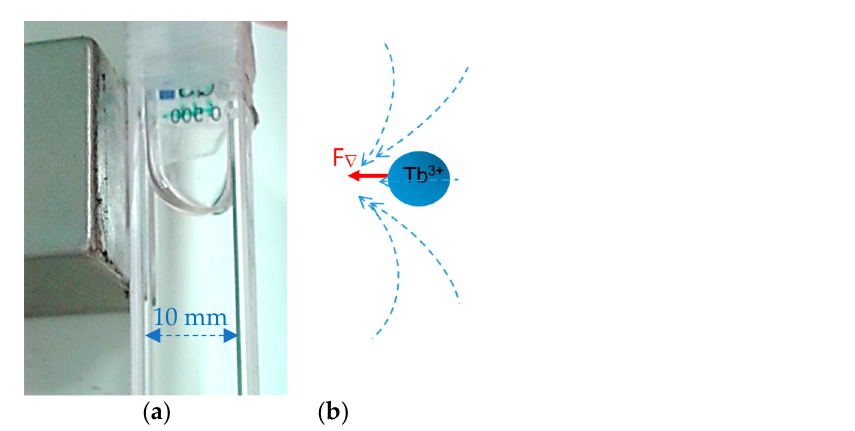
Figure 1. ( a ): Liquid rising in a bottle containing the paramagnetic solution (Tb(NO 3 ) 3 , 1M), whose surface is deformed due to the application of an inhomogeneous magnetic field (photograph). The whole solution is drawn to the pole of a 2T magnet. ( b ): The magnetic gradient force (F ∇ ) acts on the paramagnetic ions which drain the solution until equilibrating the forces by the weight of the attracted